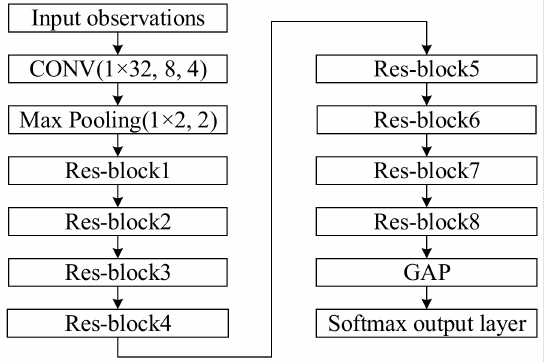
Figure 4. The complete structure of the designed ResNet. Table 1. The parameters of the convolution layer in the residual